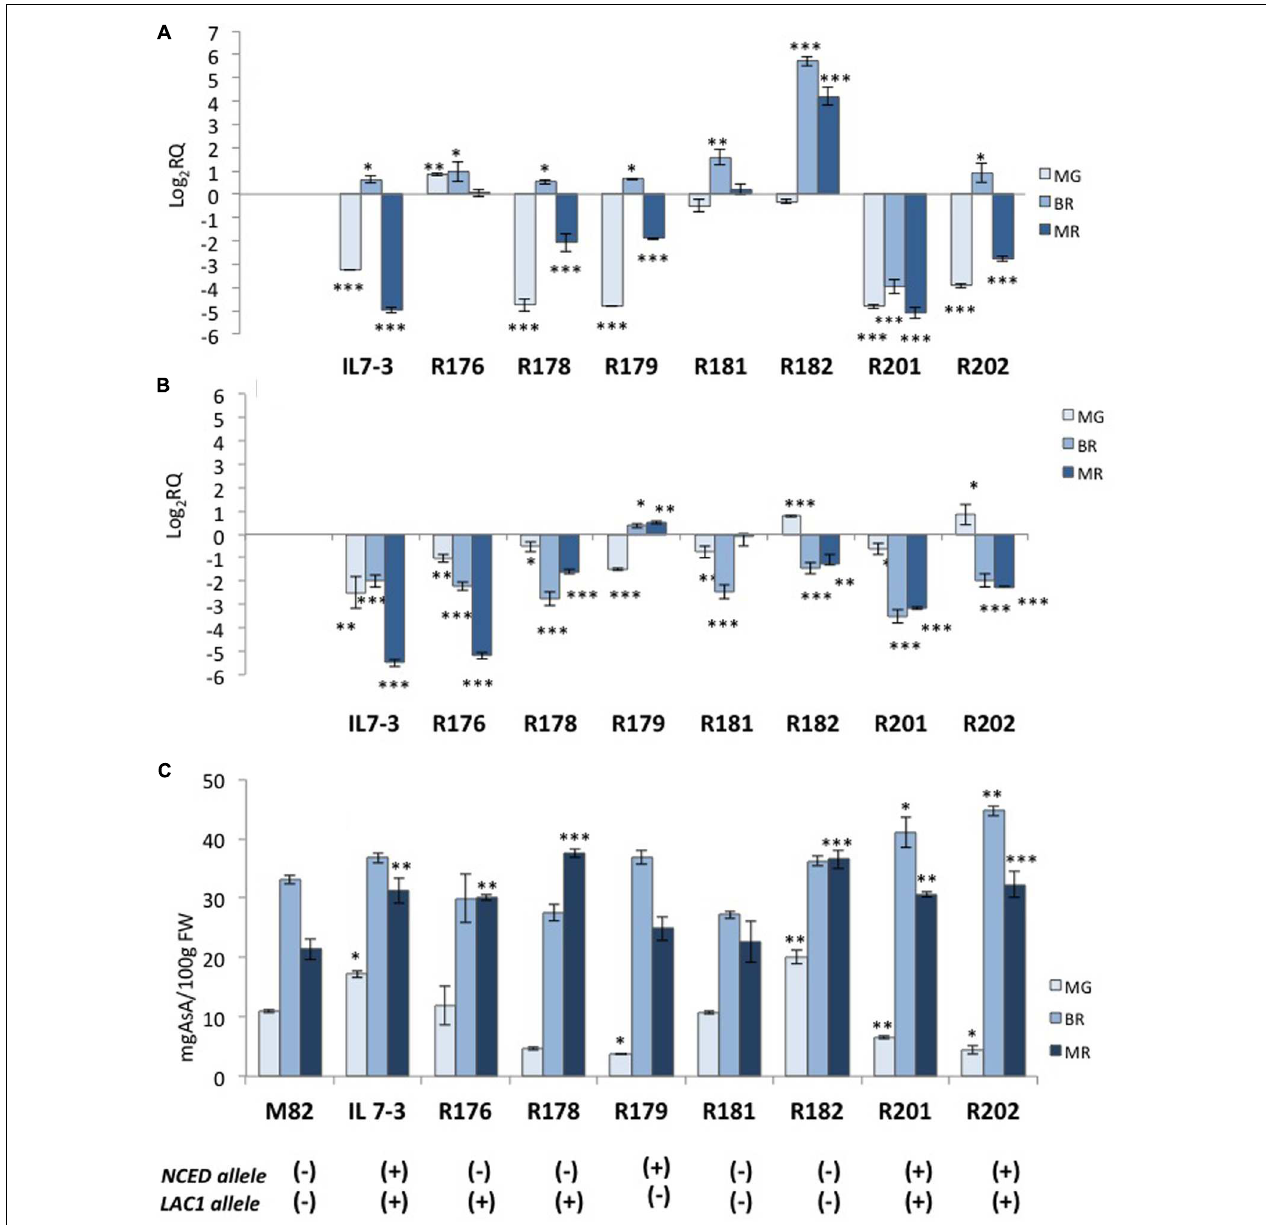
FIGURE 3 | Gene expression of two CGs ( NCED and LAC1 ) and ascorbic acid (AsA) content in the fruit of the seven sub-lines of the region 7-3. The expression level of NCED (A) and LAC1 (B) in the parental IL7-3 and its sub-lines is reported in comparison to that observed in the parental M82 at three different ripening stages, together with the AsA content (C) in the fruit evaluated at the same stages for all genotypes. Asterisks indicate statistically significant differences of each ripening stage to the corresponding M82 stage ( ∗ P < 0.05, ∗∗ P < 0.01, ∗∗∗ P < 0.001). The presence of the wild ( + ) or cultivated ( − ) alleles of NCED and LAC1 genes for each genotype is reported at the